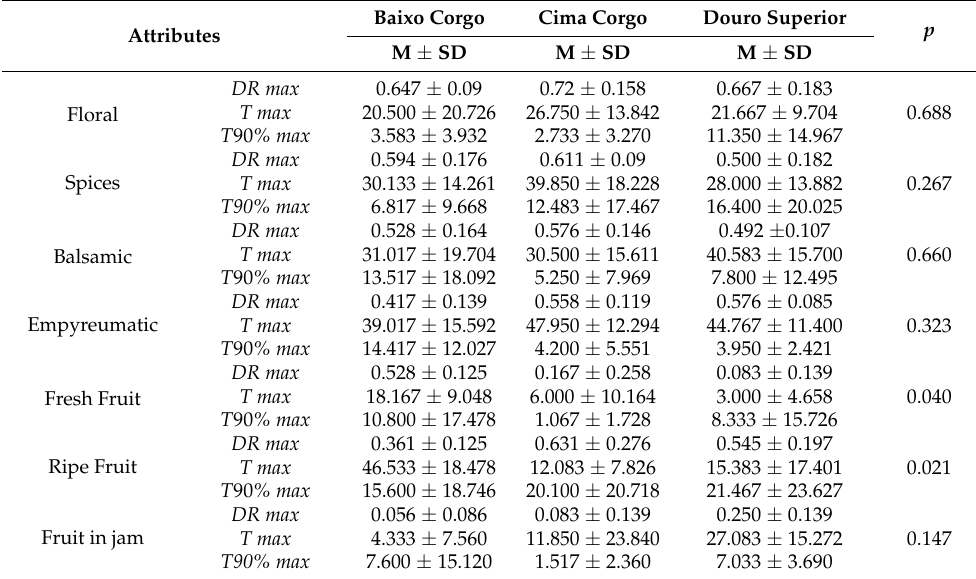
Table 9. Mean (M), standard deviation (SD), and multivariate significance of the TDS parameters— Olfactory